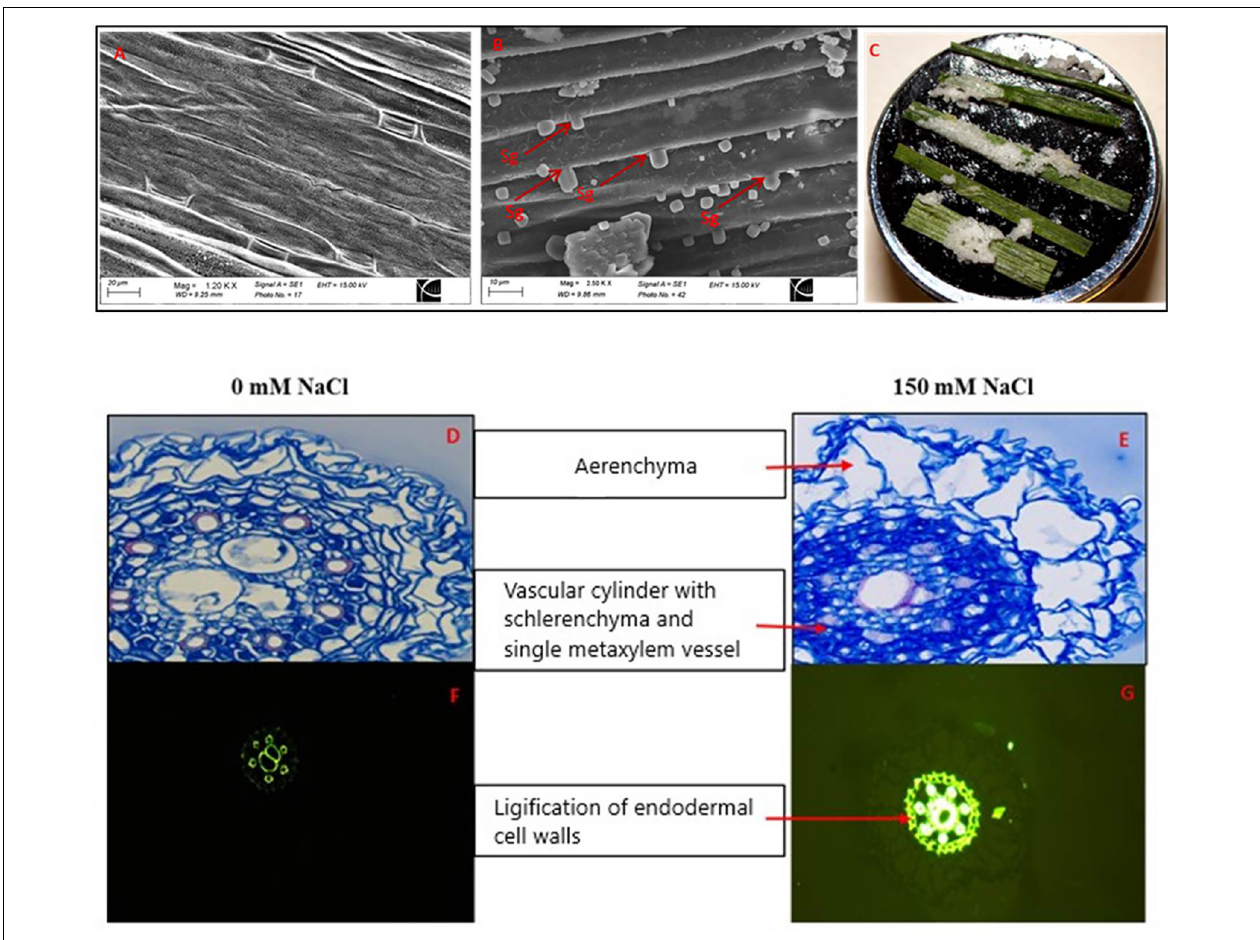
FIGURE 11 | Scanning electron micrographs of the abaxial leaf surfaces from control (A) , 150 mM (B) NaCl-treated Puccinellia nuttalliana plants for 6 days, Sg: salt gland, leaves of Puccinellia nuttalliana showing salt crystals on their surfaces after the plants were treated with 150 mM NaCl treated for 6 days (C) , root cross sections of P . nuttalliana treated for 6 days with 0 mM NaCl (D) and 150 mM (E) NaCl; lignification of the endodermal cell walls (F,G) visualized by fluorescence. Cross section were made after 6 days of 0 mM (F) and 150 mM NaCl (G)